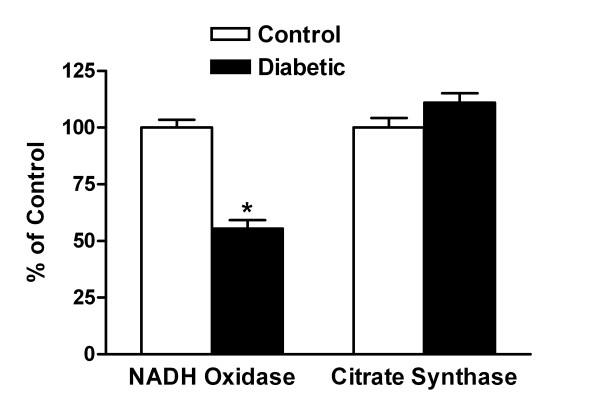
Effect of diabetes on mitochondrial NADH oxidase and citrate synthase activity. Mitoplasts were prepared from frozen hearts (n = 5) isolated from control and 4-week diabetic mice. Following solubilization of the mitoplasts, NADH oxidase and citrate synthase activity were measured as described. Values represent the mean ± SD. *P < 0.001 vs. control.